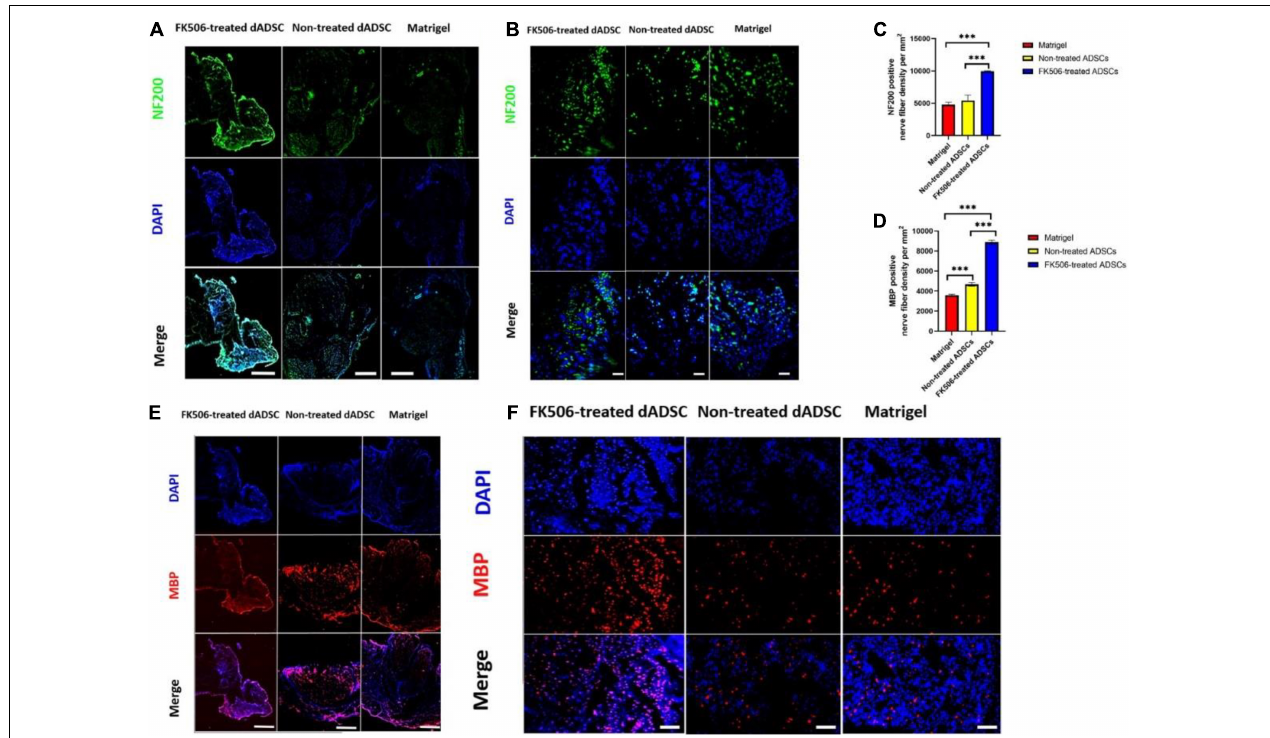
FIGURE 7 | (A,B) The immunofluorescence (IF) photographs of the regenerated axons. NF-200 positive axons were stained with green fluorescence. The nuclei were stained with blue fluorescence. Scale bar is 50 µ m for (A) and 10 µ m for (B) . (C,D) The mean density of regenerated axons which were NF-200 positive and the mean density of myelinated nerve fibers which were MBP-positive. ∗∗∗ P < 0.001. (E,F) The IF photographs of the myelinated nerve fibers. MBP positive axons were stained with red fluorescence. The nuclei were stained with blue fluorescence. Scale bar is 50 µ m for (E) and 20 µ m for (F)